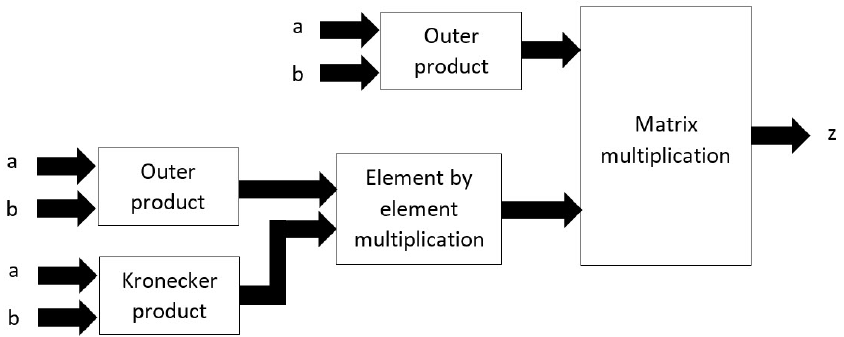
Figure 6. Visualization of the algorithm in Python and